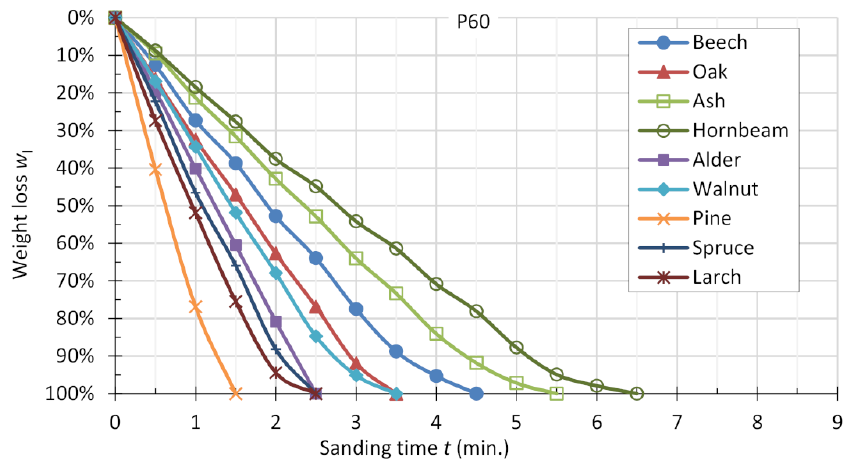
Figure 6. Average percentage weight loss of specimens sanded with abrasive belt P60.